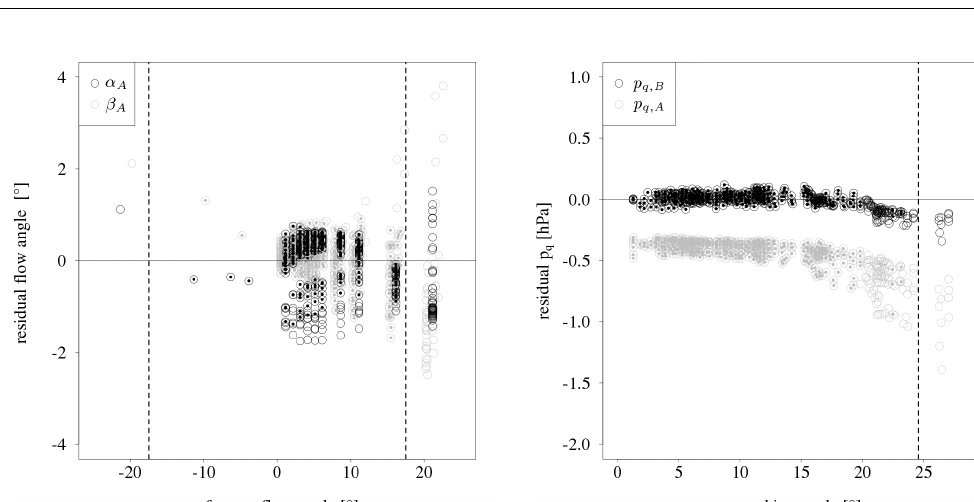
Fig. 7. Wind tunnel evaluation results: open circles represent the residuals for all combinations of flow angles ( α A , β A , left) and dynamic pressure before ( p q , A ) and after ( p q , B ) wind tunnel correction (right). Full circles indicate subsets that lie in the (extended) operational flow angle range of ± 17.5 ◦ . These subsets are used for the uncertainty assessment. Dashed vertical lines indicate the corresponding thresholds of flow angle and working angle (acos ( cos α cos β) ), respectively.